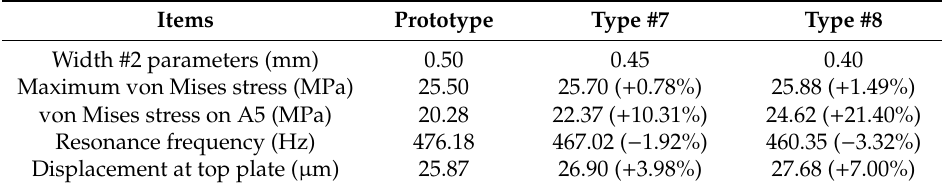
Figure 21. von Mises stress distribution on spring with different width #2 parameters. Table 6. Analysis result comparison between different width #2 parameters. Table 6. Analysis result comparison between di ff erent width #2 parameters.